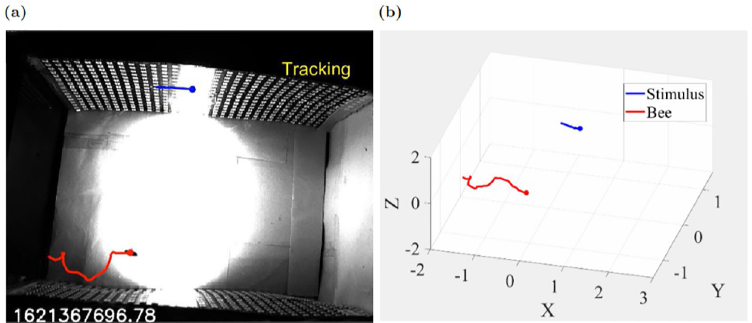
Fig 4. (a). Tracking trajectory of bee (red) and stimulus (blue) and “Tracking” text indicates tracking period, (b). their 3d trajectories.